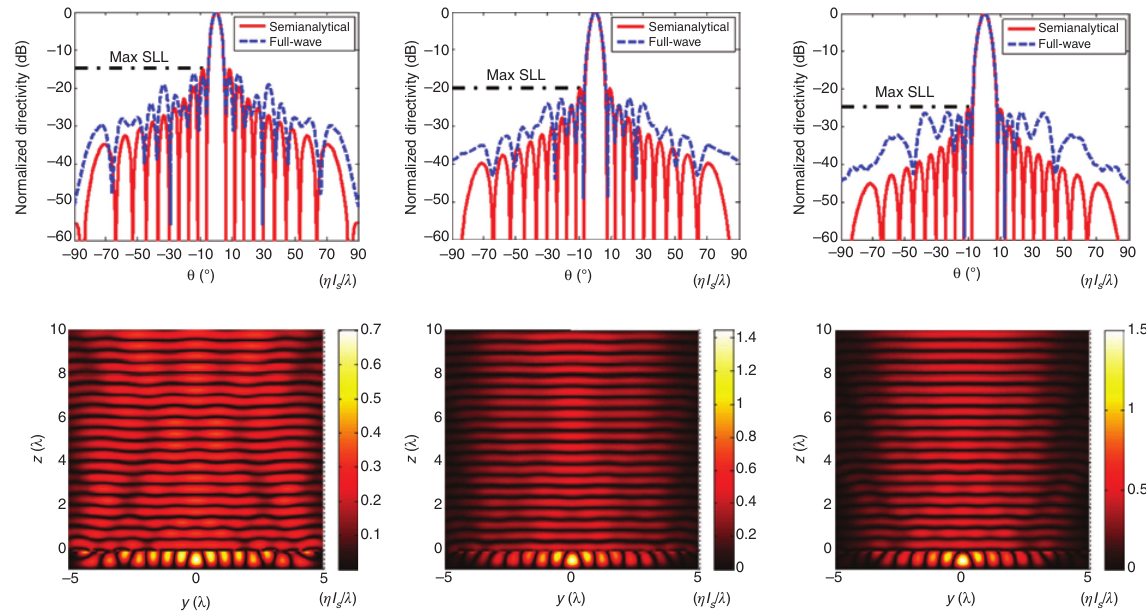
Figure 14: Fullwave simulations of cavity excited bianisotropic HMS antenna for Taylor distribution showing controllable side lobe levels. Obtained from Ref.